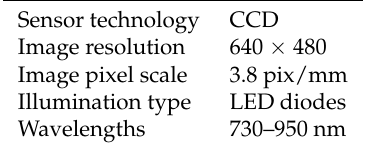
Table 1. Hardware characteristics of the equipment used for the creation of GustoDB biometric database.